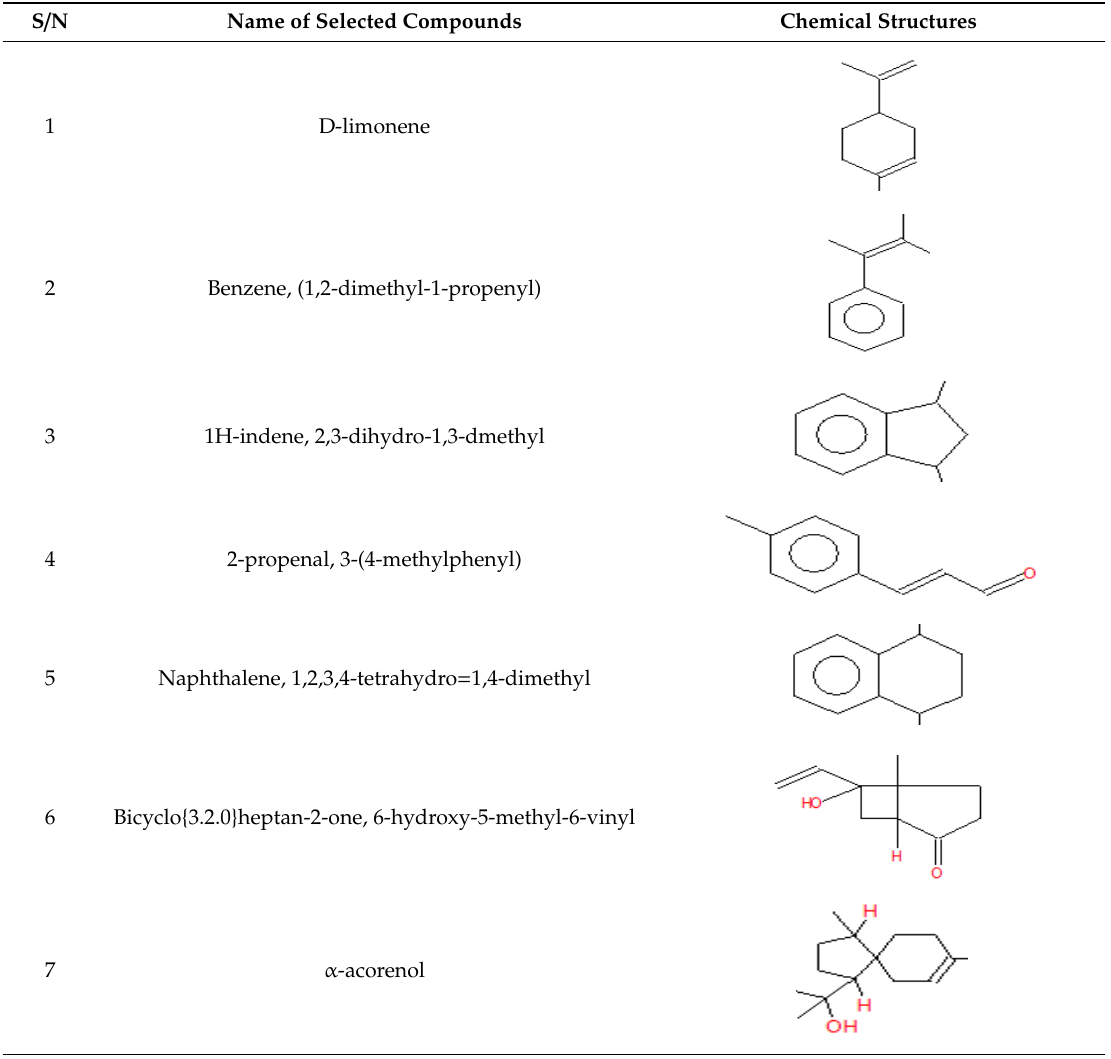
Table 1. Identified compounds and their structures.